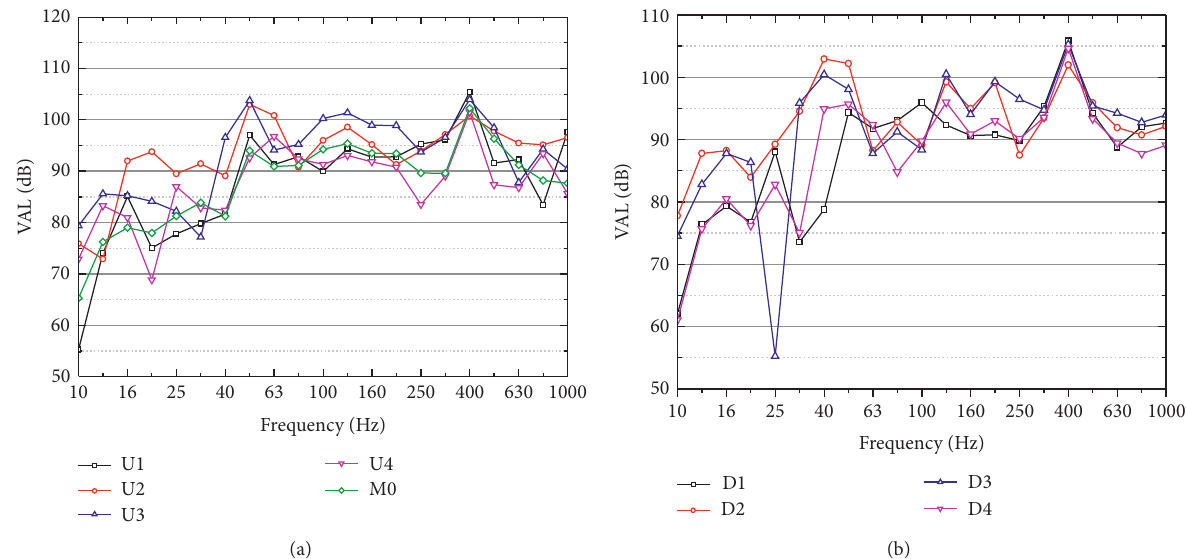
Figure 15: VAL distribution along the circumference of the steel arch: (a) upbound vibration; (b) downbound vibration.